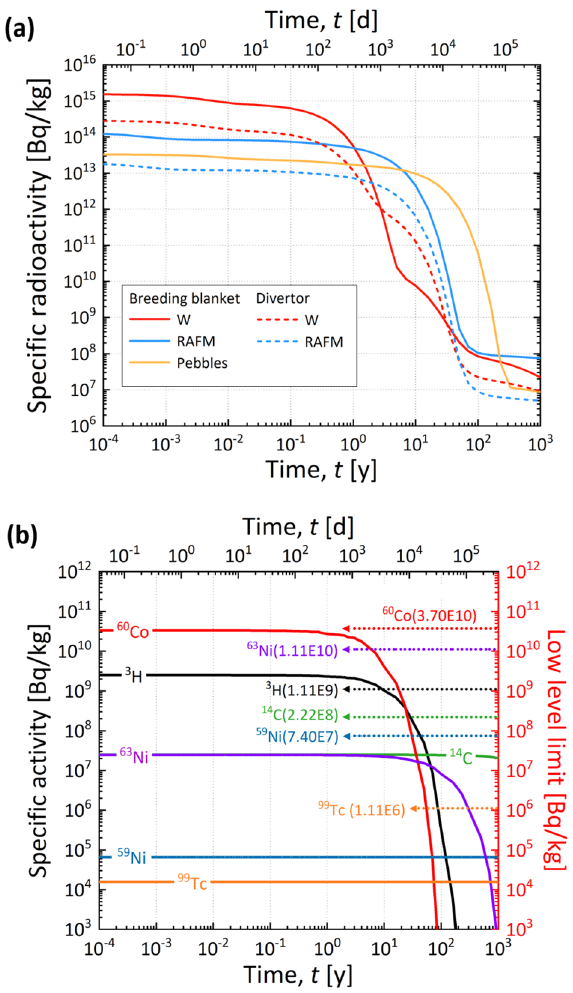
Figure 4. Transient radioactivity of the in-vessel components of K-DEMO: ( a ) Specific radioactivity levels of the breeding blankets and divertor. ( b ) Radioactivity of nuclides from the structural material of reduced activation ferritic martensitic (RAFM) steel and the functional pebble materials of the breeder (Li 4 SiO 4 ) and neutron multiplier (Be 12 Ti). Dotted lines from the right of the y-axis indicate low-level limits of the nuclides prescribed by Korean regulations.